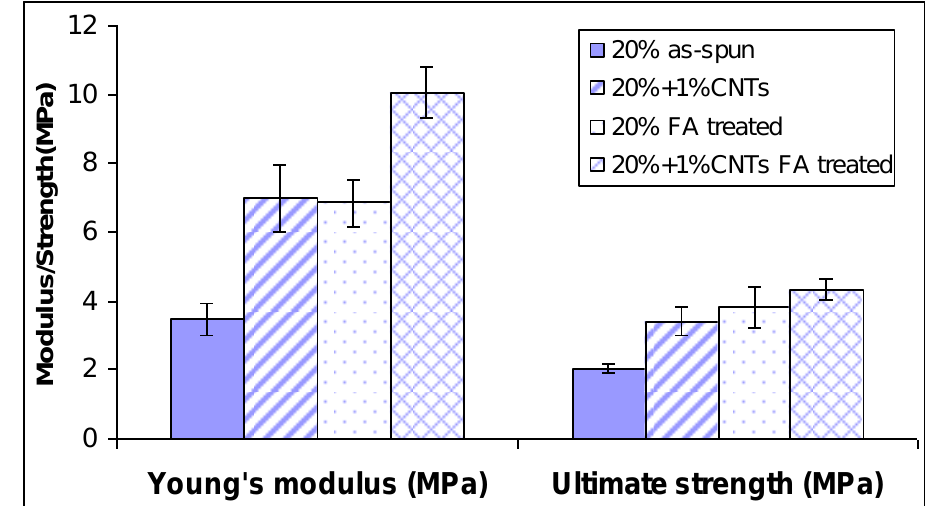
Figure 7. Typical stress-strain plots of nylon 6 non-woven fiber mats electrospun from 20 wt %, and